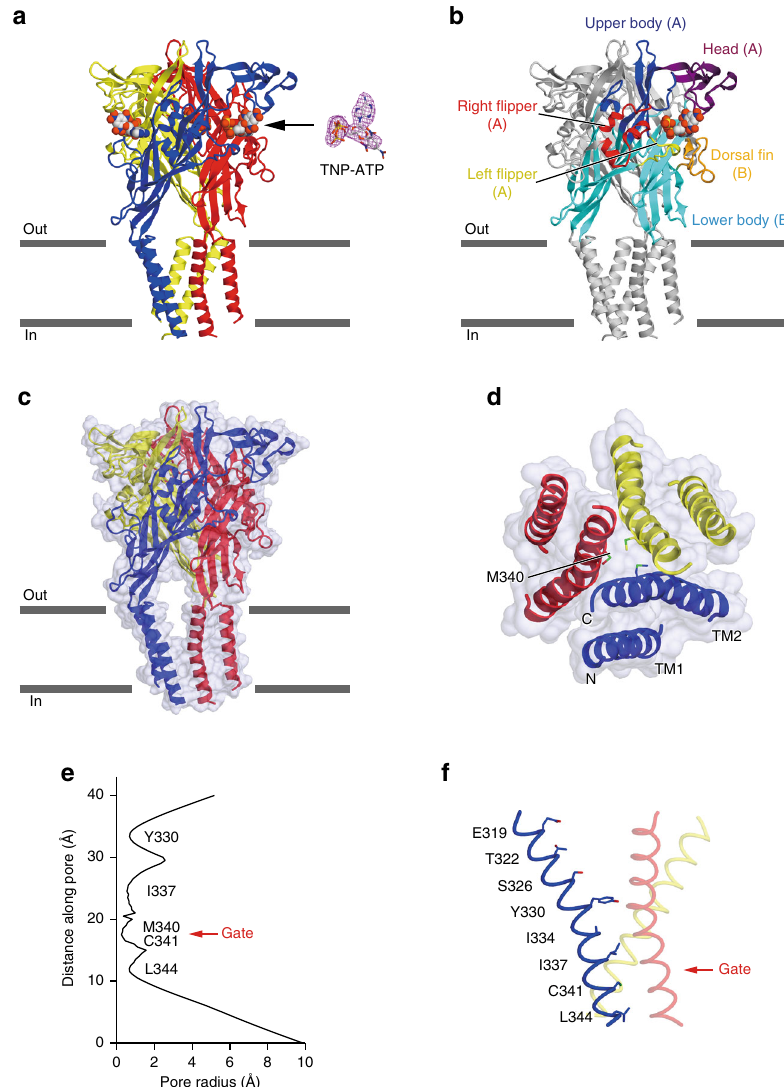
Fig. 2 The architectures of the TNP-ATP-bound ckP2X7 structure. a The TNP-ATP-bound ckP2X7 structure, viewed parallel to the cell membrane. The blue , red , and yellow colors correspond to each subunit. The omit F o – F c density map contoured at 2.5 σ is presented for the TNP-ATP molecular density. b The recognition manner of TNP-ATP. The molecule is colored according to the dolphin-like model 20 . c The surface model with a cartoon representation of the TNP-ATP-bound ckP2X7 structure. d The surface model with a cartoon representation of the transmembrane domain in the TNP-ATP-bound ckP2X7 structure, viewed from the intracellular side. Amino-acid residues involved in the pore constriction region are depicted by stick models. e The pore radius for the TNP-ATP-bound ckP2X7 structure along the pore center axis. The pore size was calculated with the program HOLE. f Pore-lining residues of the TNP-ATP-bound ckP2X7 structure are shown in stick